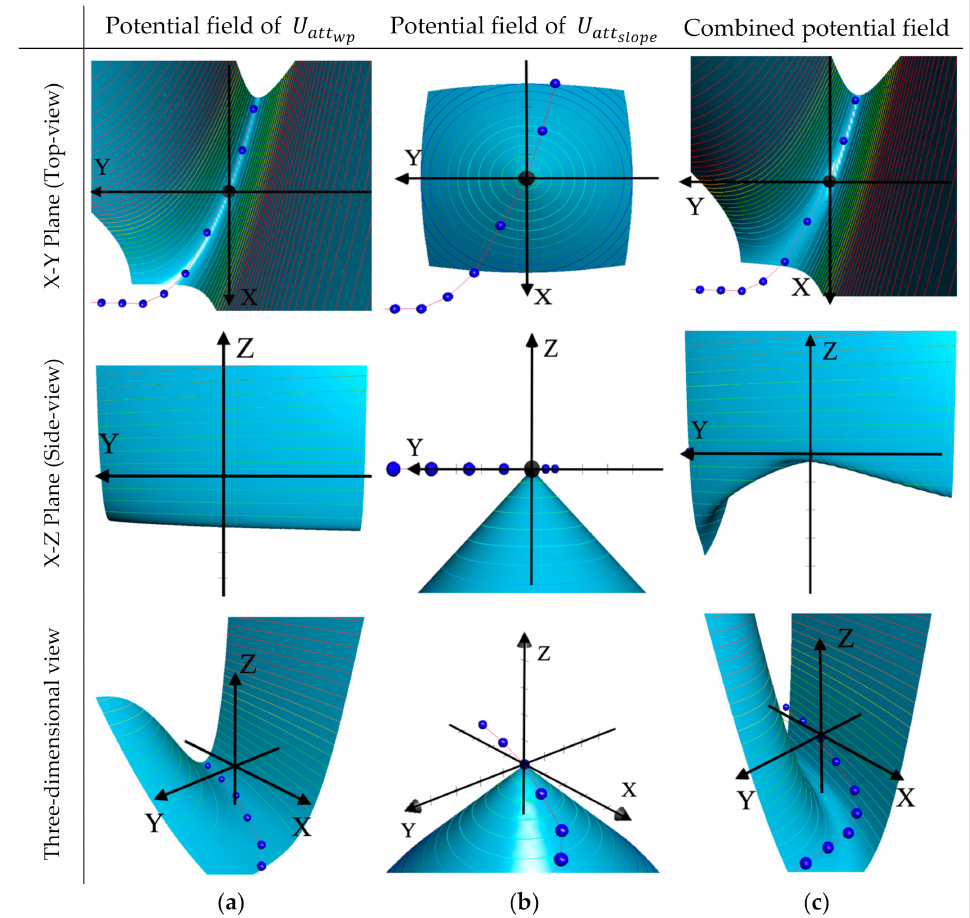
Figure 4. Potential field visualization drawn on three-dimensional Cartesian coordinates. The contour line denotes the height of the cost value. The blue circle denotes the reference path points. The red line, crossing the zero point, denotes the Bayesian polynomial calculated from the reference path points. The zero point (0, 0, 0) mean the center of gravity of the micro-EV. ( a ) Denotes Equation (6). The potential valley is shown through the x-y plane; ( b ) denotes Equation (7). The slope is shown through the x-z plane; ( c ) denotes the sum of Equation